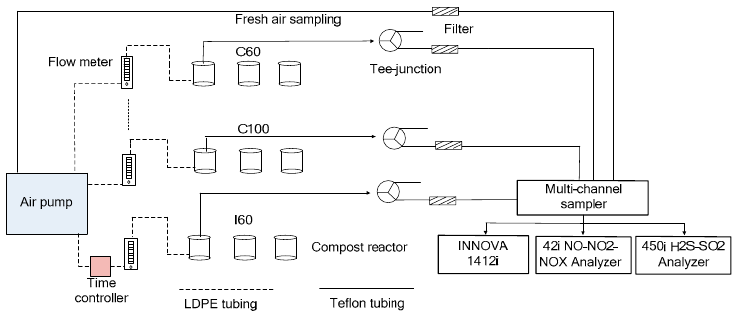
Figure 1. Schematic of the experimental setup. C60—continuous aeration with a rate of 60 L · min − 1 · m − 3 , C100—continuous aeration with a rate of 100 L · min − 1 · m − 3 , I—intermittent aeration with an average rate of 60 L · min − 1 · m − 3